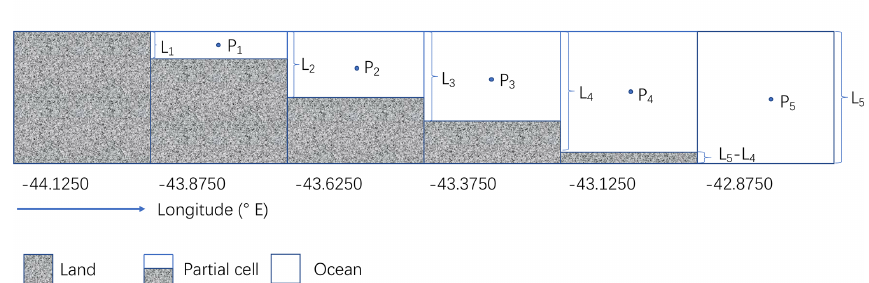
Figure C1. Some model grid boxes that include land, partial cells, and ocean with longitudes from − 44 . 1250 to − 42 . 8750 ◦ E, a latitude of 83.3750 ◦ S and a depth of 298.3048m. L i is the fraction of the level thickness that is ocean, P i is the pressure at the centre of the grid box and i is the index of the grid